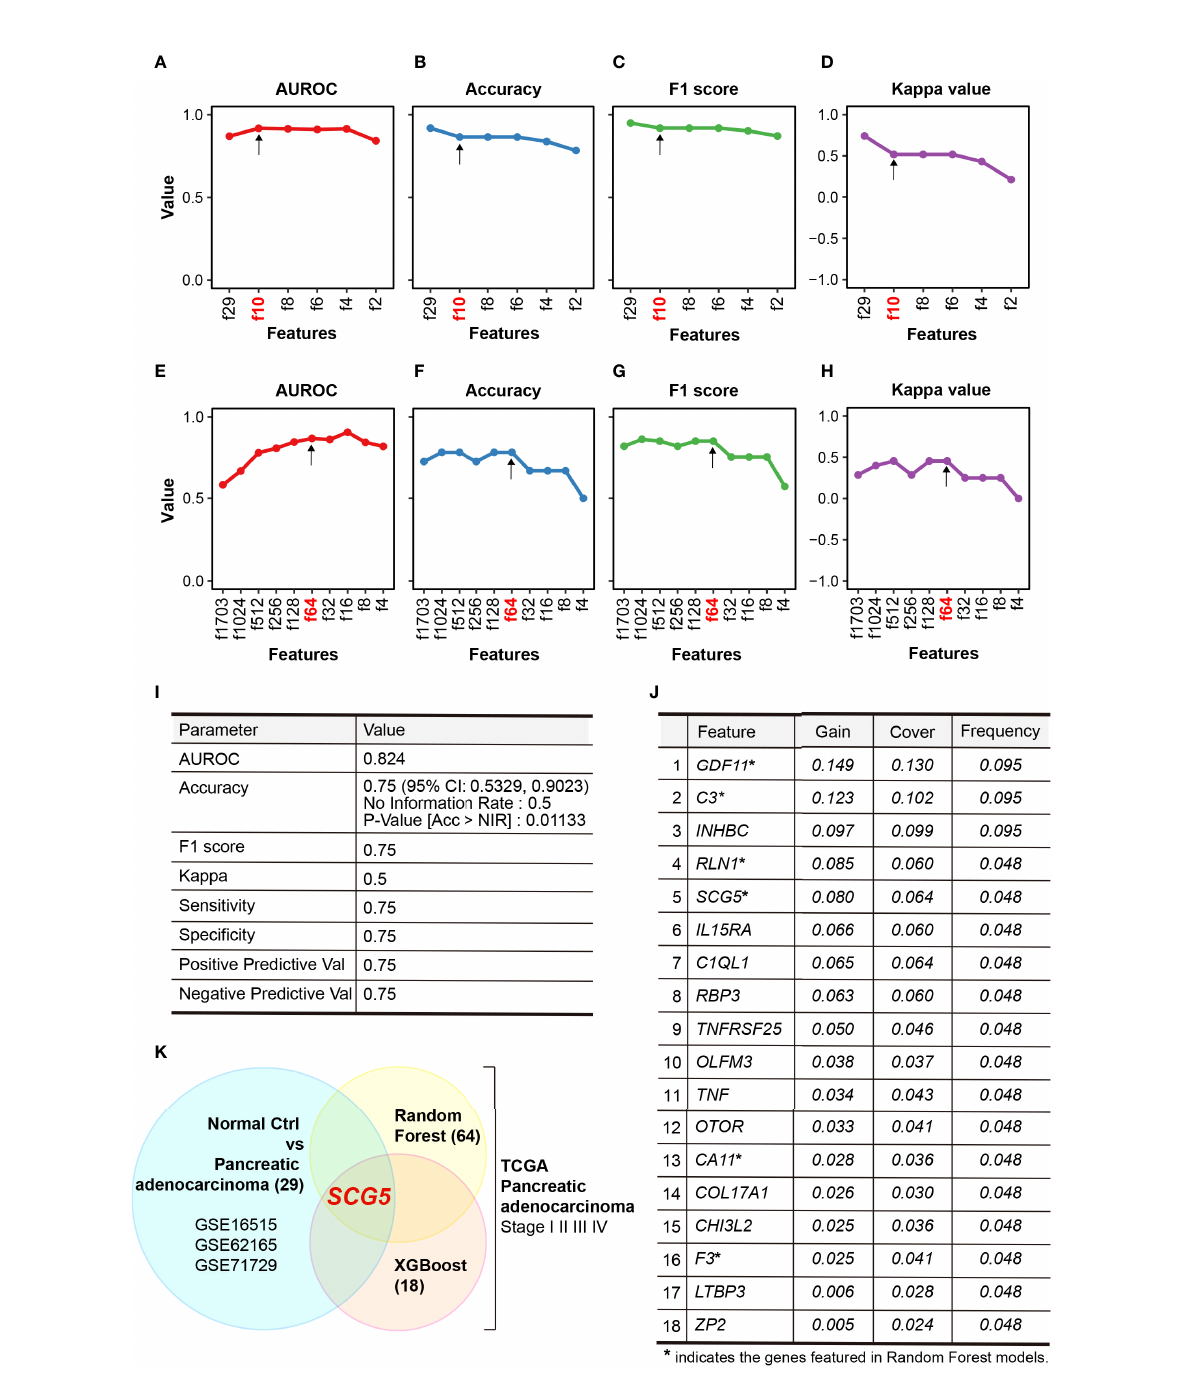
FIGURE 2 Performance of constructed random-forest (RF) models. (A – D) Plots summarizing the area under receiver operating characteristic curve (AUROC) (A) , accuracy (B) , F1 score (C) , and kappa value (D) of RF models that classi fi es normal pancreas and pancreatic adenocarcinoma. (E, F) Plots highlighting the AUROC (E) , accuracy (F) , F1 score (G) , and kappa value (H) of RF models that characterize the prognosis of PAC. (I, J) Tables summarizing the performance (I) and selected features (J) of XGBoost modeling, (K) Venn diagram showing SCG5 as the only common feature in two distinct ML